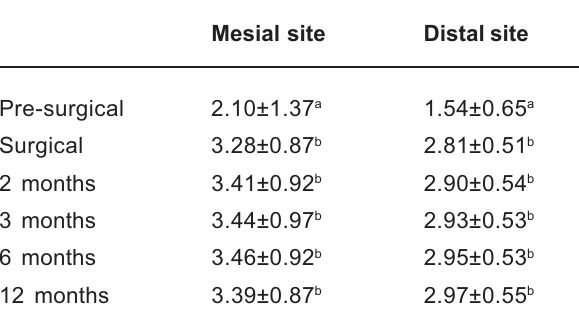
Means followed by different letters in the same column are statistically different at 5% by the Tukey’s test.